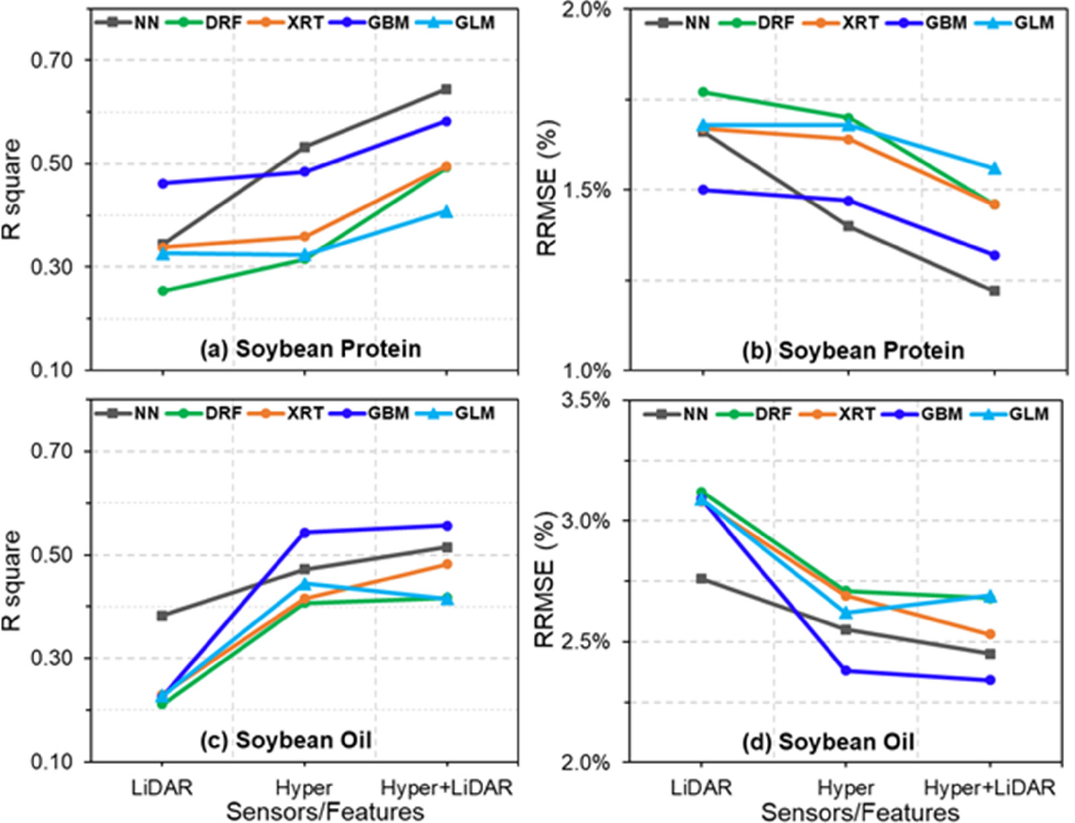
Figure 13. R 2 and RRMSE metrics when predicting soybean protein and oil composition based on Hyperspectral, LiDAR and Hyper + LiDAR data using different machine-learning methods. (R 2 : Coefficients of Determination, RRMSE: Relative Root Mean Square Error; NN: Deep Neural Network, DRF: Distributed Random Forest, XRT: Extremely Randomized Trees, GBM: